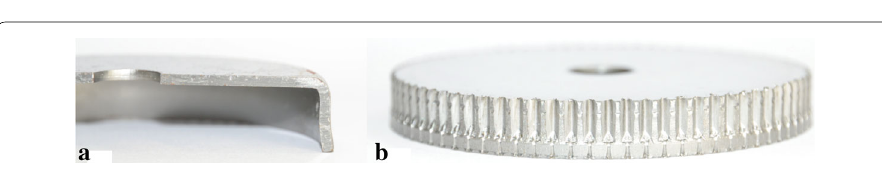
Fig. 10 Demonstrator of the collaborative research project TR73. A cut out a after the first, b after the second stage of the forming